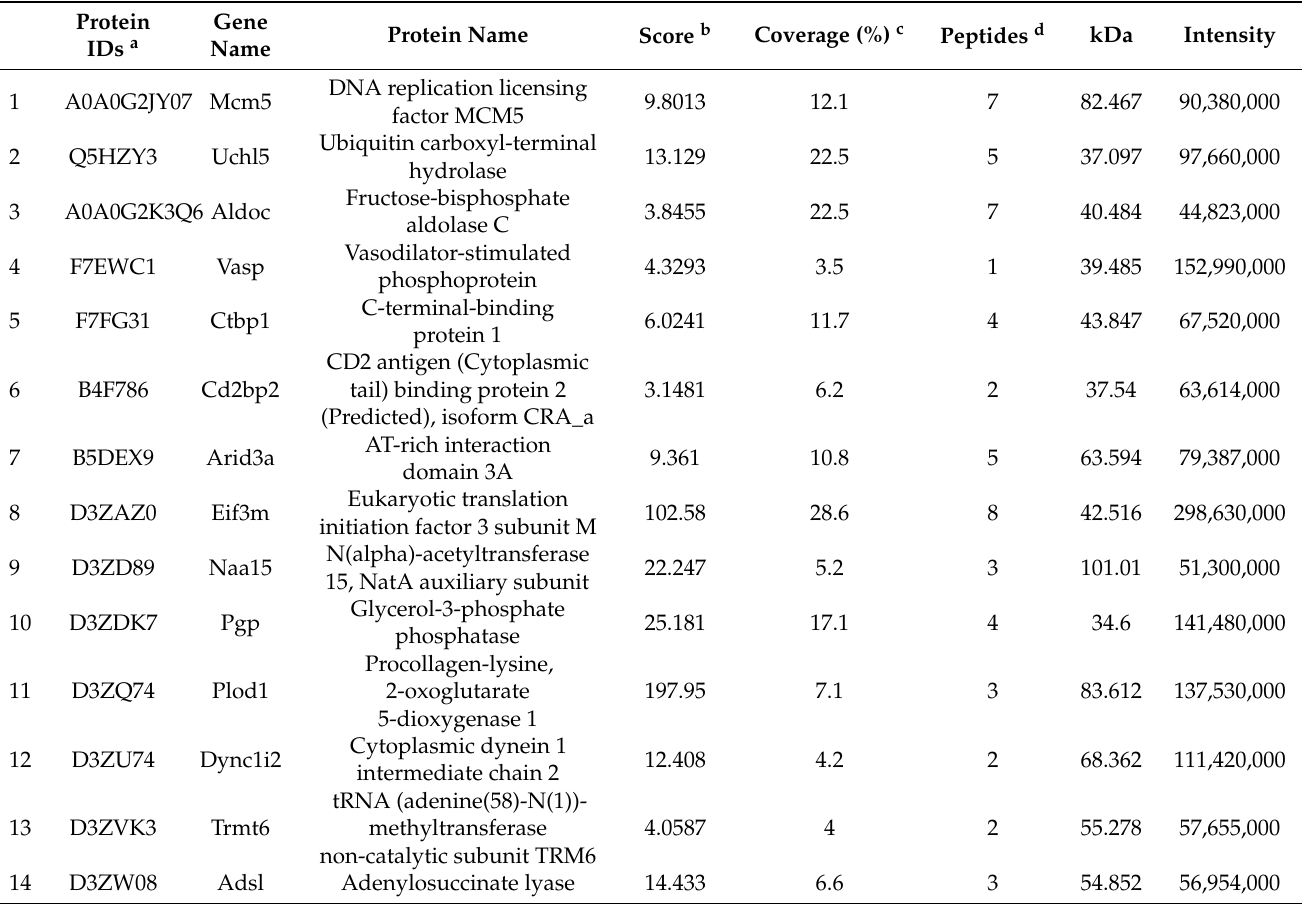
Table 3. nLC-MS identified HepG2 proteins that only are found after treatment with